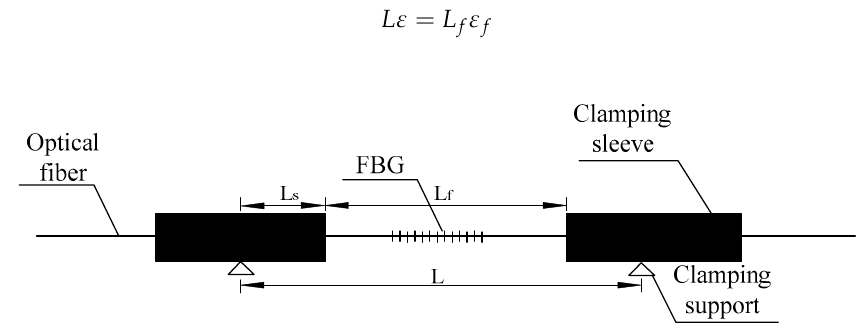
Figure 6. Working principle and structure diagram of sensitized FBG sensor.